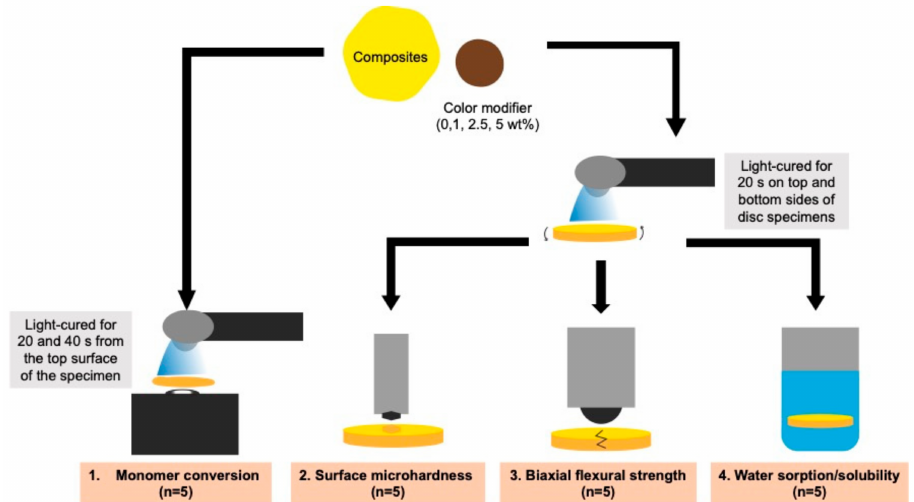
Figure 2. Schematic illustrating the methods used in the current